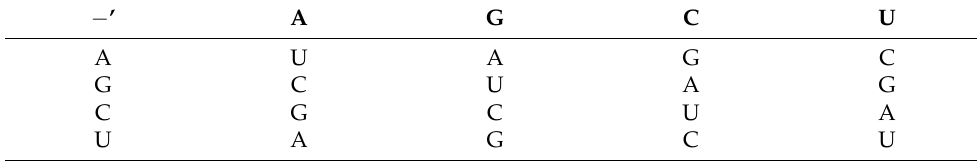
Table 6. RNA sub-complement rule.